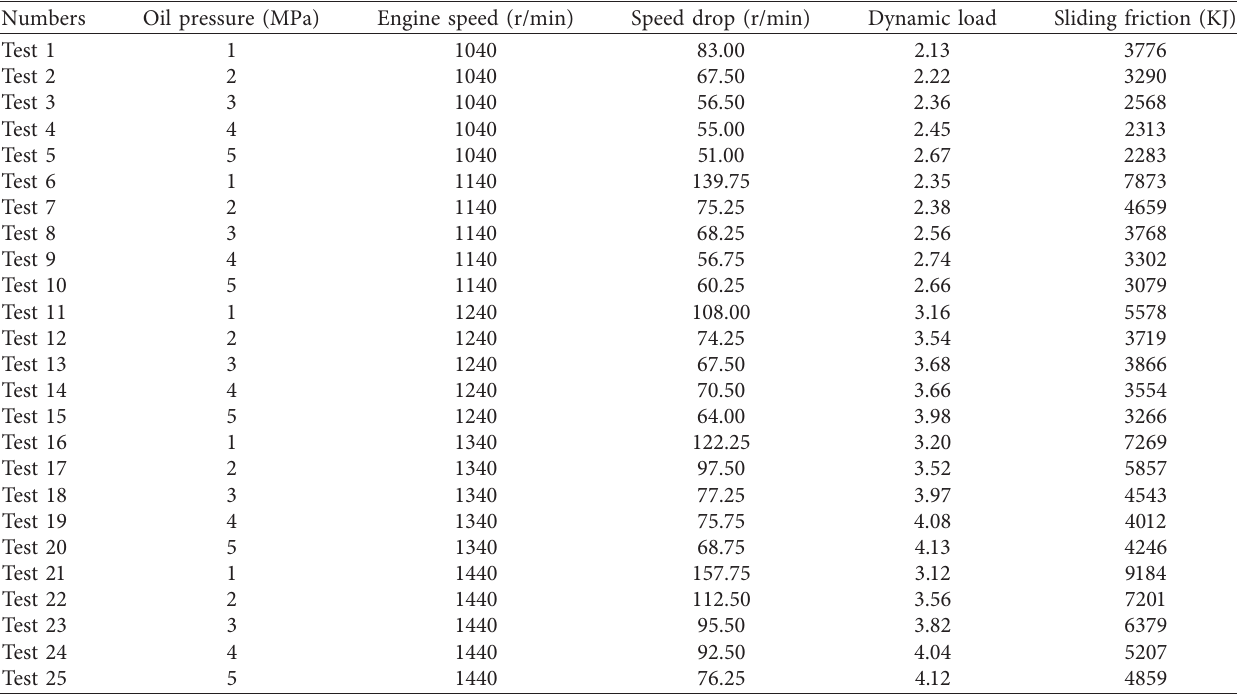
Table 1: Table of factors and levels.